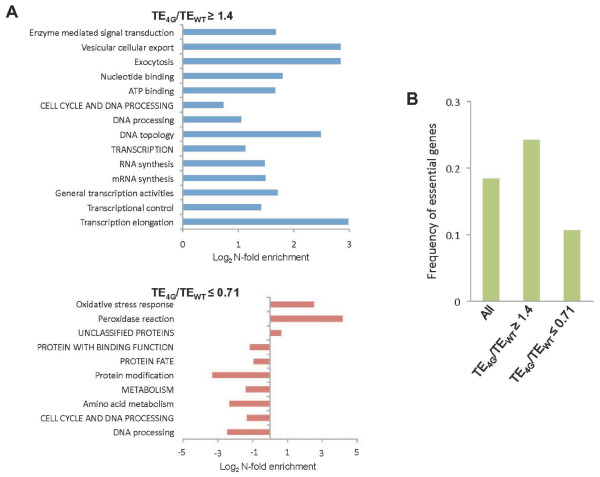
Characteristics of genes exhibiting altered translational efficiencies on depletion of eIF4G.(A) Cellular functions enriched among mRNAs translated relatively better (TE4G/TEWT ≥1.4) or relatively worse (TE4G/TEWT ≤ 0.71) on eIF4G depletion. The degree of enrichment (Log2 N-fold enrichment) as compared to the frequency among all tested genes for significantly enriched or underrepresented functional categories (P < 0.05, Fisher's exact test, Bonferroni correction) is shown. Functional enrichment was analyzed using the MIPS Funcat system (http://mips.helmholtz-muenchen.de/genre/proj/yeast/Search/Catalogs/catalog.jsp) (B) Frequency of essential genes within the complete set of tested genes (All) and among genes with TE4G/TEWT ≥1.4 or TE4G/TEWT ≤ 0.71. The frequency of essential genes in the latter two categories deviate significantly from the frequency for all tested genes (Fisher's exact test; P < 0.05).